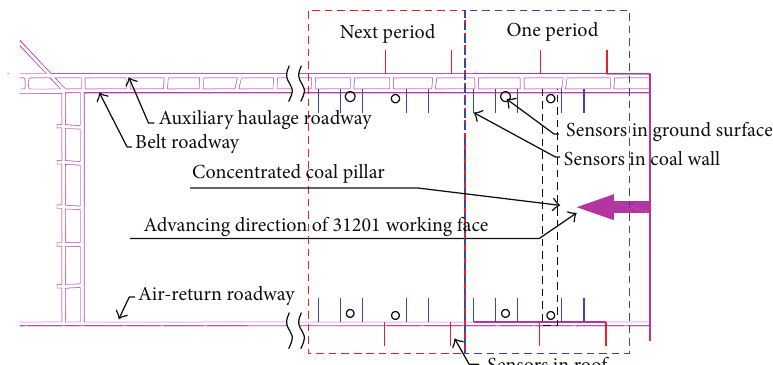
Figure 6: Sensors arrangement and